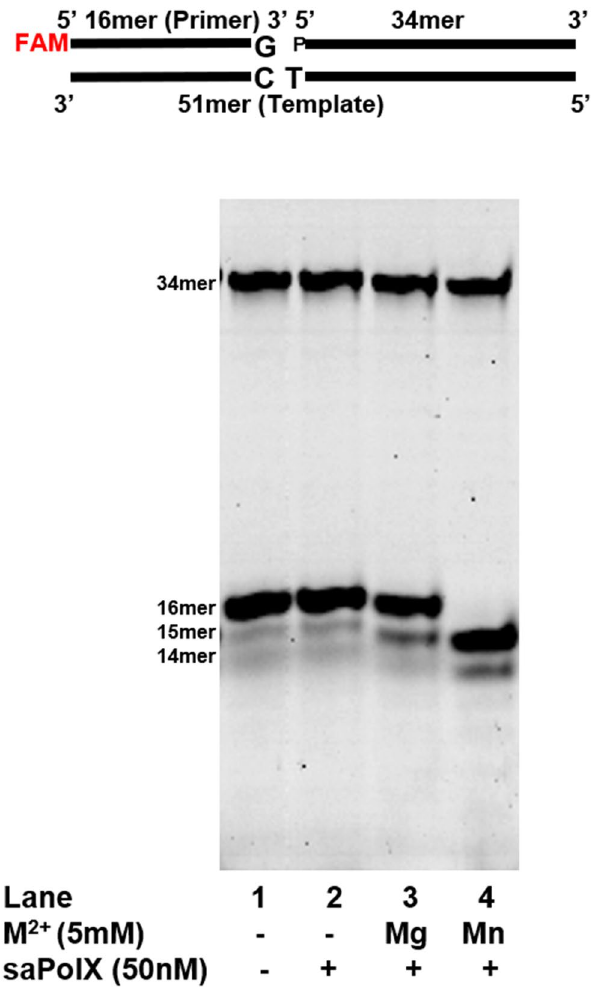
Figure 9. Metal ions required for optimal exonuclease activity of saPolX. The exonuclease activity was tested in the presence of Mg 2+ and Mn 2+ metal ions for wt-saPolX which was treated with 0.2 M EDTA during purification. The gapped DNA substrate (C:G) is displayed at the top of the gel. LC represents the loading control (6FAM labelled 34mer DNA oligonucleotide) added in each lane for quantification. The result shows that wt-saPolX degrades ~ 20% and 100% substrate in the presence of Mg 2+ and Mn 2+ metal ions, respectively. The experiments show that wt-saPolX prefers Mn 2+ metal ion to exhibit exonuclease